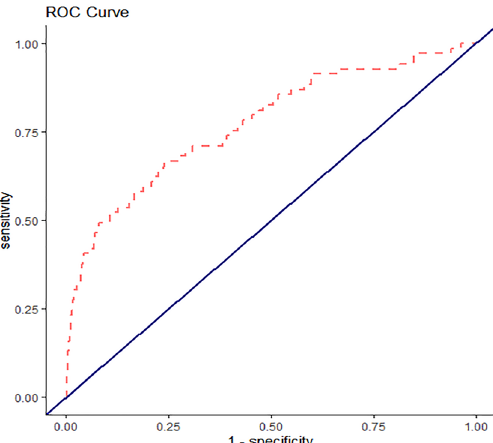
Figure 1. Receiver operating characteristic curve for seven-day mortality with the Emergency Heart Failure Mortality Risk Grade.